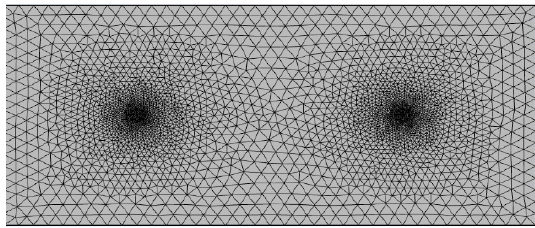
Figure 2. Local refined mesh of the two orifices. Table 1. Computed domain cell